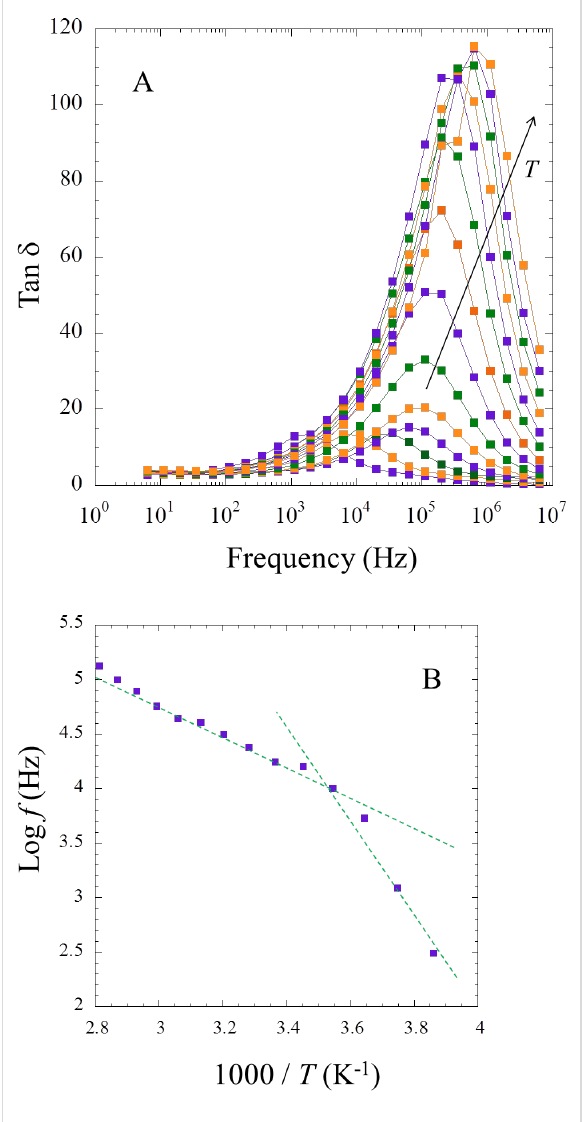
Figure 14: Variation of (A) tan δ vs log f and (B) relaxation time vs 1000/ T for MBA40. The temperature is as follows: 1000/ T (K − 1 ) = 3.861, 3.745, 3.643, 3.545, 3.452, 3.364, 3.282, 3.204, 3.130, 3.060, 2.994, 2.930, 2.870, 2.813.